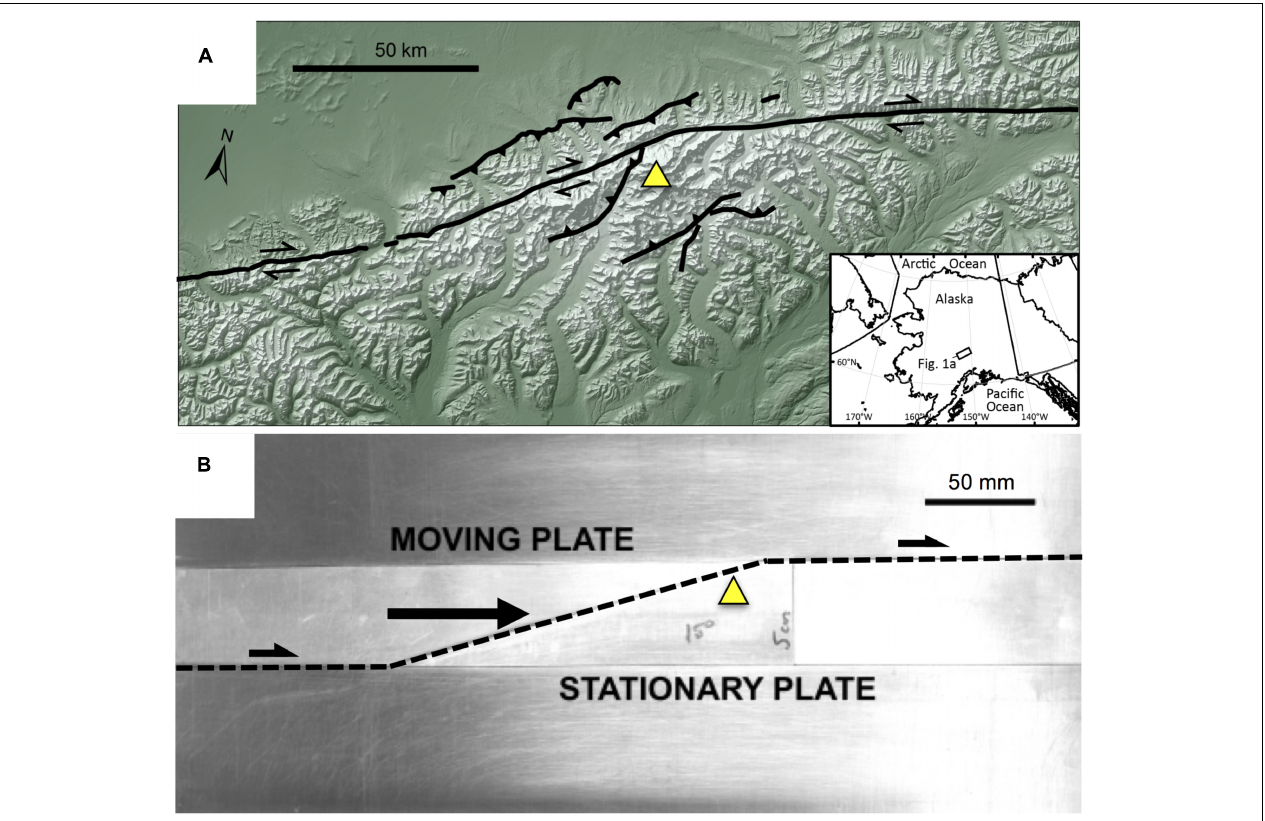
FIGURE 1 | (A) Digital elevation model of the Mt. McKinley restraining bend with Denali peak (triangle) and fault trace indicated. Fault traces simplified from Haeussler (2008), Koehler et al. (2012), and Burkett et al. (2016). Shaded-relief base derived from the 2 arcsecond National Elevation Dataset DEM (https://nationalmap.gov/). (B) Basal plate restraining bend configuration (15 ◦ , 5 cm stepover) for experimental